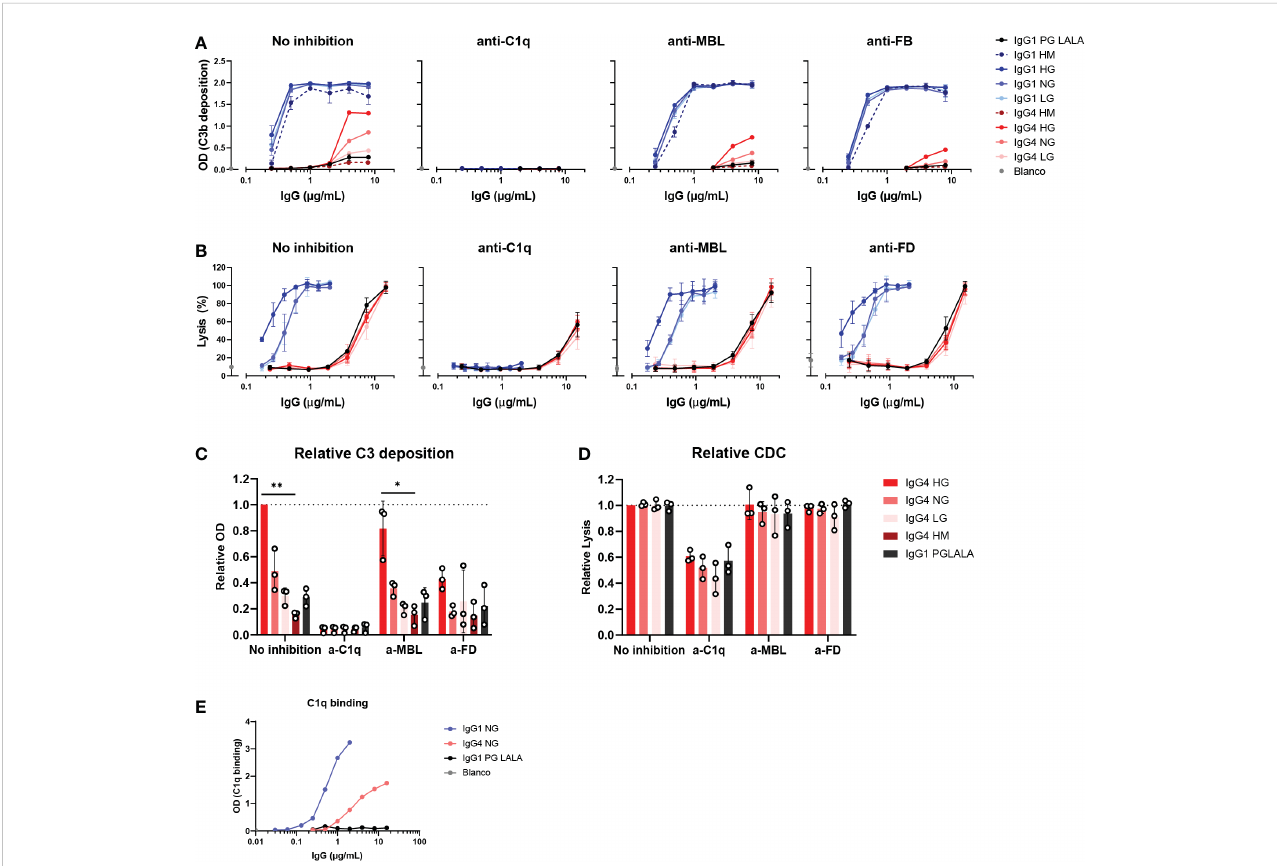
FIGURE 4 IgG4 activates complement via the classical pathway. (A) C3b deposition by anti-biotin IgG1, IgG4 and IgG1 PG-LALA (eliminated Fc-mediated effector functions) in presence or absence of either C1q, mannose-binding lectin (MBL), or complement factor B (FB) inhibitors, biotinylated human serum albumin (HSA; 240 m M biotin) and 2.5% human serum. Antibodies with different glycan pro fi les were tested: high mannose (HM), high galactose (HG), normal galactose (NH) and low galactose (LG). The molar ratios of target to inhibitor are 1:4.5 for C1q, 1:8.5 for MBL, and 1:3.5 for FB. (B) The percentage of complement-mediated lysis of biotinylated human red blood cells (2.5 mM biotin) by IgG1, IgG4 and IgG1 PG-LALA in presence or absence of C1q, MBL, or factor D (FD) inhibitors and 10% human serum. The molar ratios for target to inhibitor were 1:3 for C1q, 1:3 for MBL, and 1:2 for FD. The percentage of lysis was calculated based on the 100% lysis control (red blood cells with saponin). (C) The relative C3b deposition and (D) percentage of complement-mediated lysis of biotinylated human red blood cells induced by IgG4 glycovariants are shown as bar graphs with an antibody concentration of either (C) 8 µg/mL, or (D) 15 µg/mL. (E) To test binding of puri fi ed C1q (600 m g/mL) to the mAbs, IgG1, IgG4 and IgG1 PG-LALA were tested in the presence of biotinylated human serum albumin (HSA; 240 m M biotin). Kruskal-Wallis test with Dunn ’ s multiple comparisons test was performed for statistical comparison of the IgG4 glycovariants per inhibition condition: *p < 0.05; **p < 0.01. All antibodies were tested in a two-fold serial dilution starting from 8 µg/mL for C3b deposition and 15 µg/mL for CDC in at least three independent